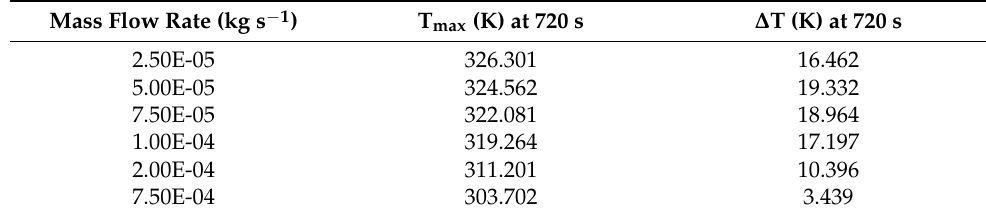
Table 5. Influence of mass flow rate at 720 s–HCD.